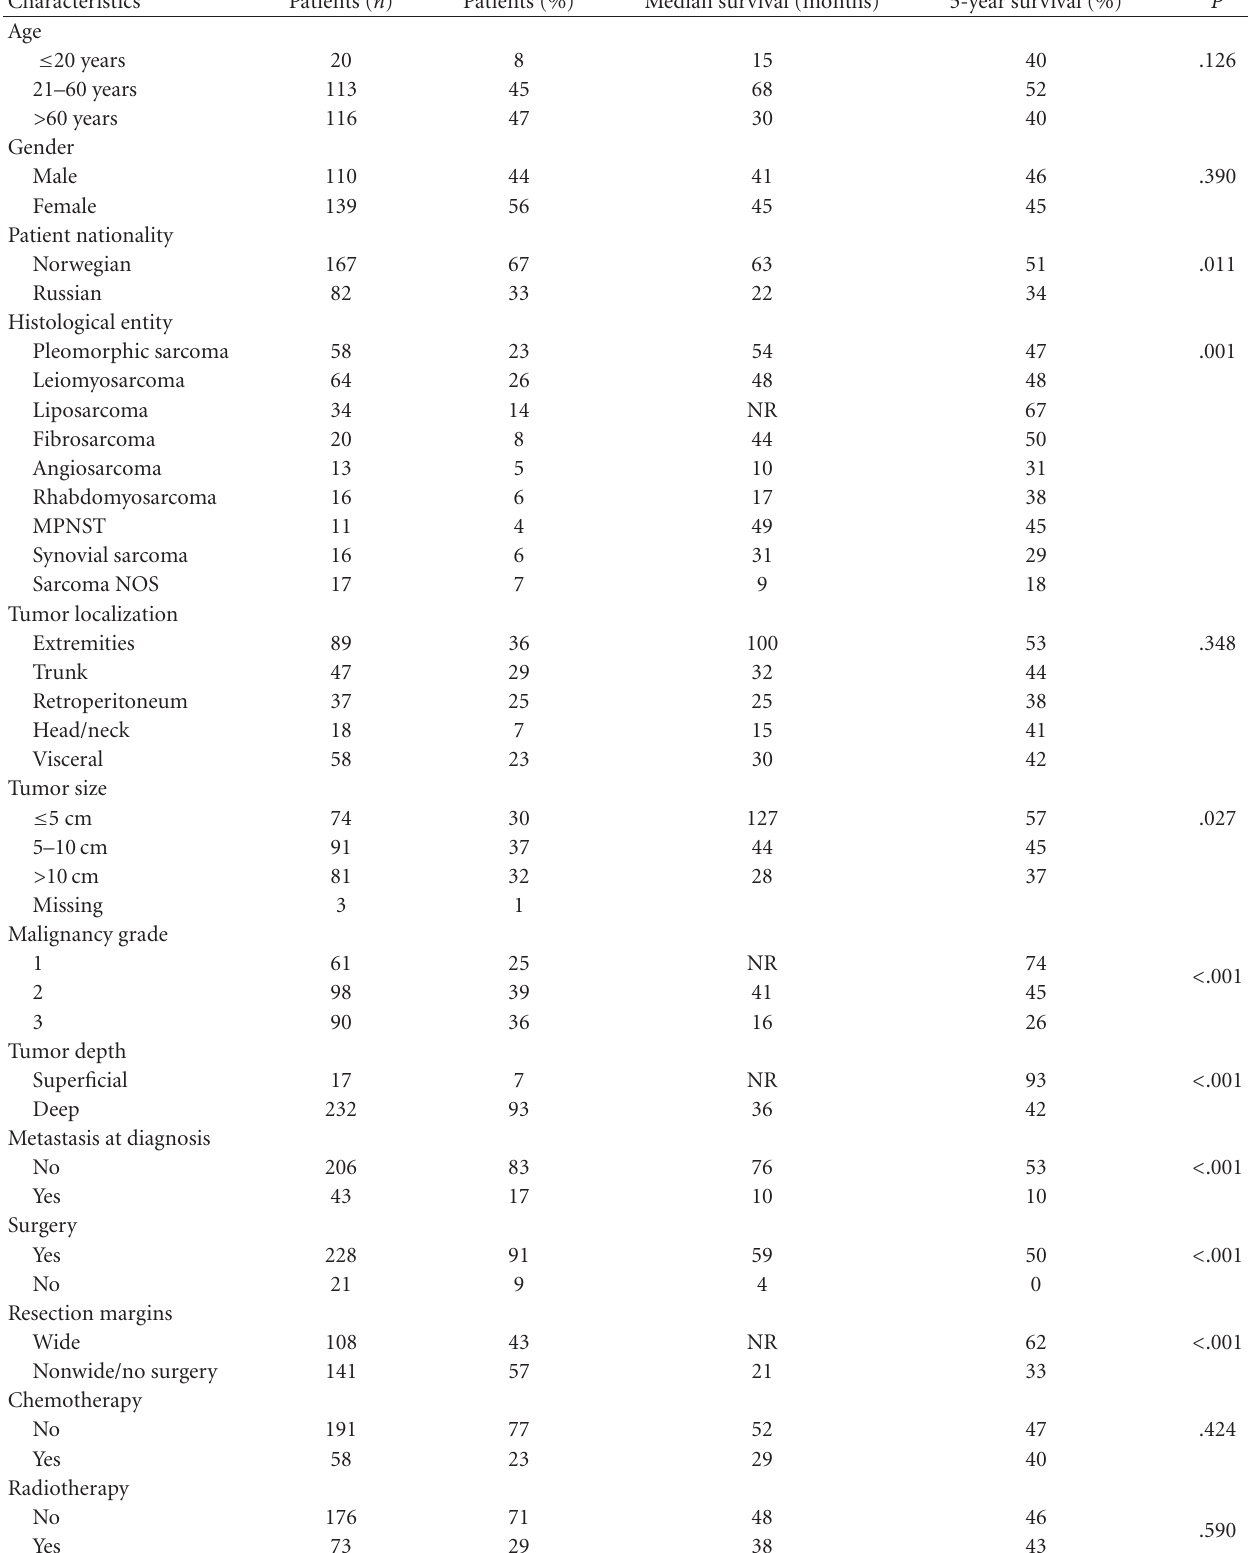
Table 1: Prognostic clinicopathological variables as predictors for disease-specific survival in 249 nongastrointestinal stromal tumor soft- tissue sarcomas (univariate analyses; log-rank